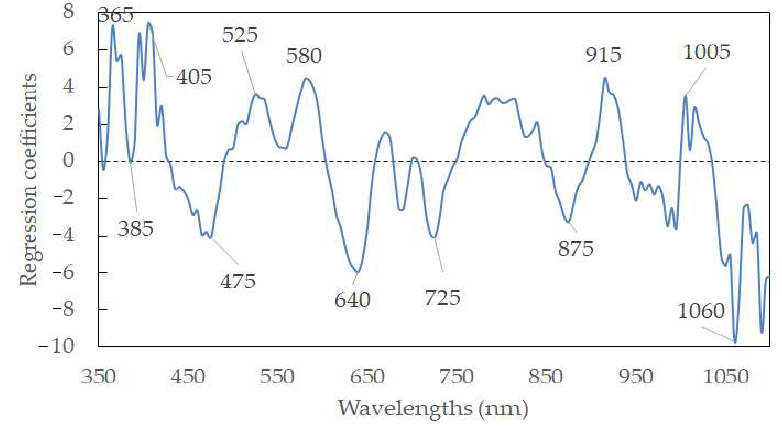
Figure 5. Feature wavelength selection from the PLSR model.